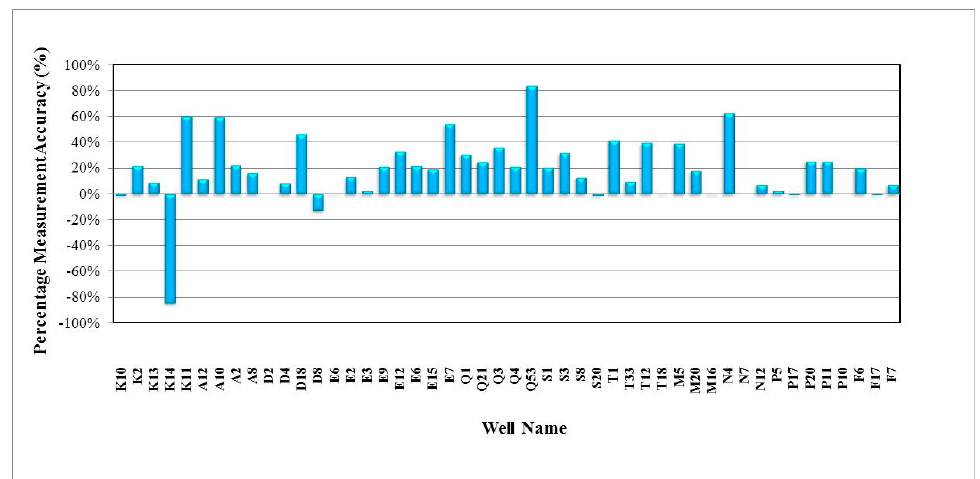
Figure 20. Oil rate measurement accuracy using the Darcy correlation.